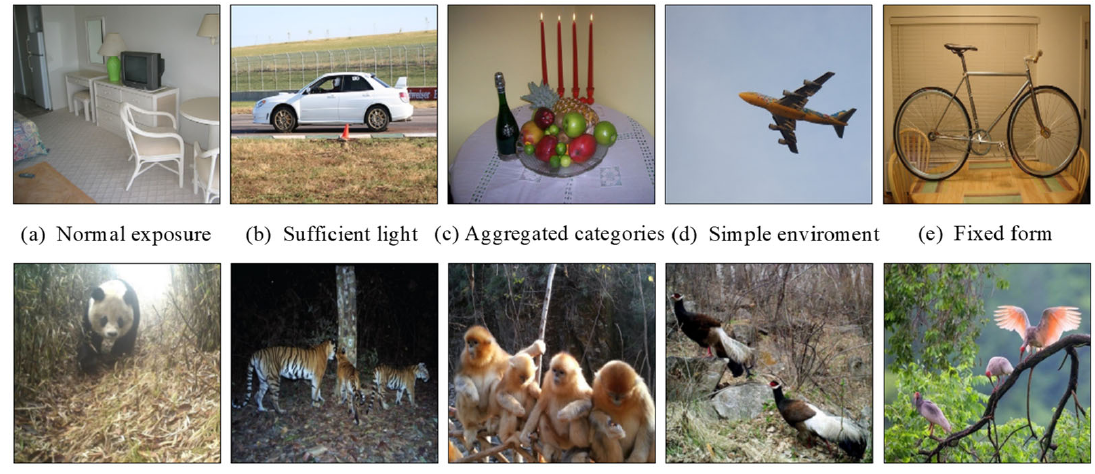
Figure 5. Example of the contextual gaps among images on the public dataset ( a – e ) and pictures of endangered animals ( f – j ).